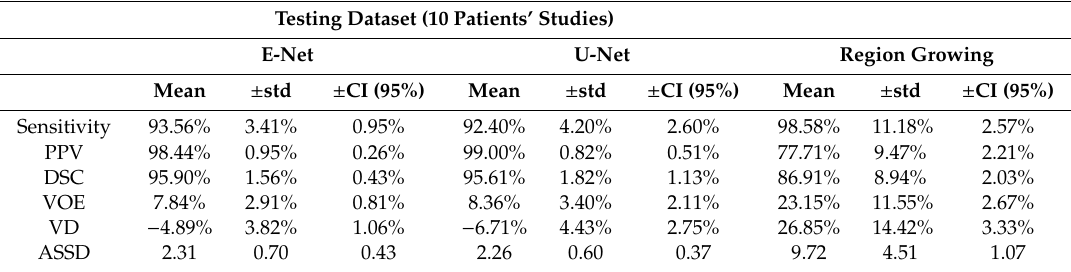
Table 2. Performance results for the testing dataset (10 patient studies) obtained as the average of the results computed from each Net trained in the five folds, and using the region growing algorithm.